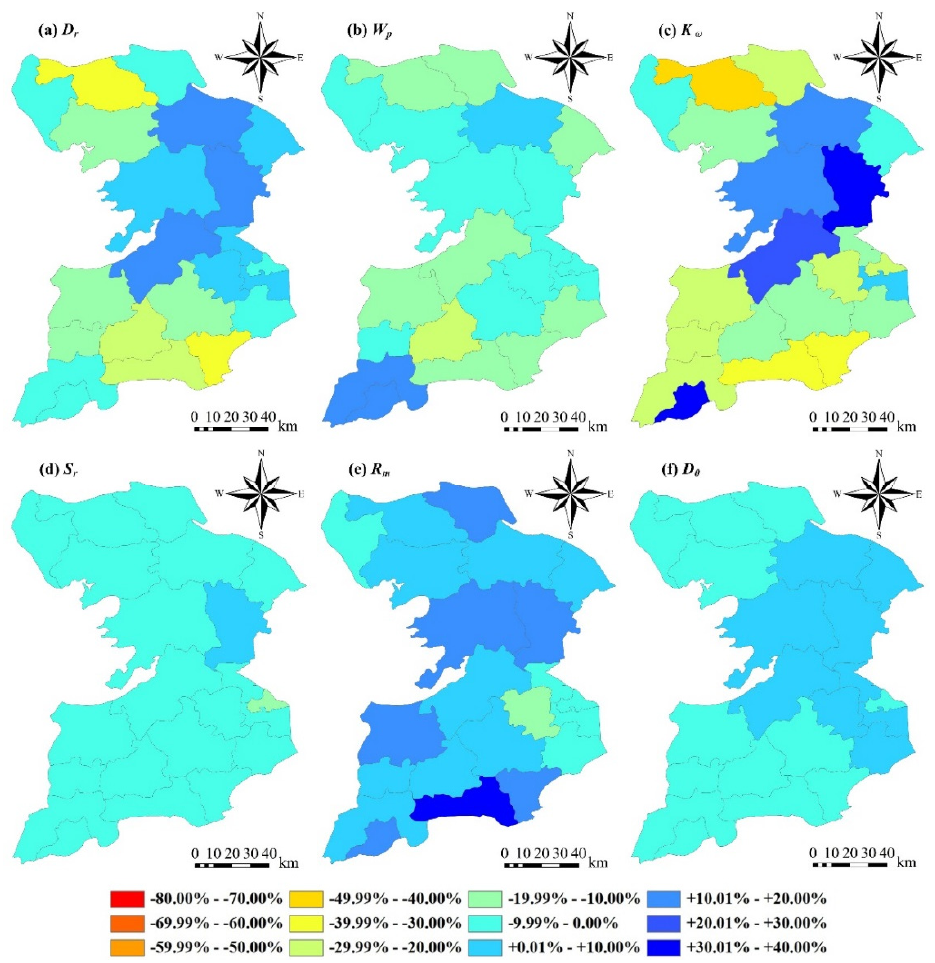
Figure 4. Spatial difference of river system changes in the Taihu Region during the 1960s to